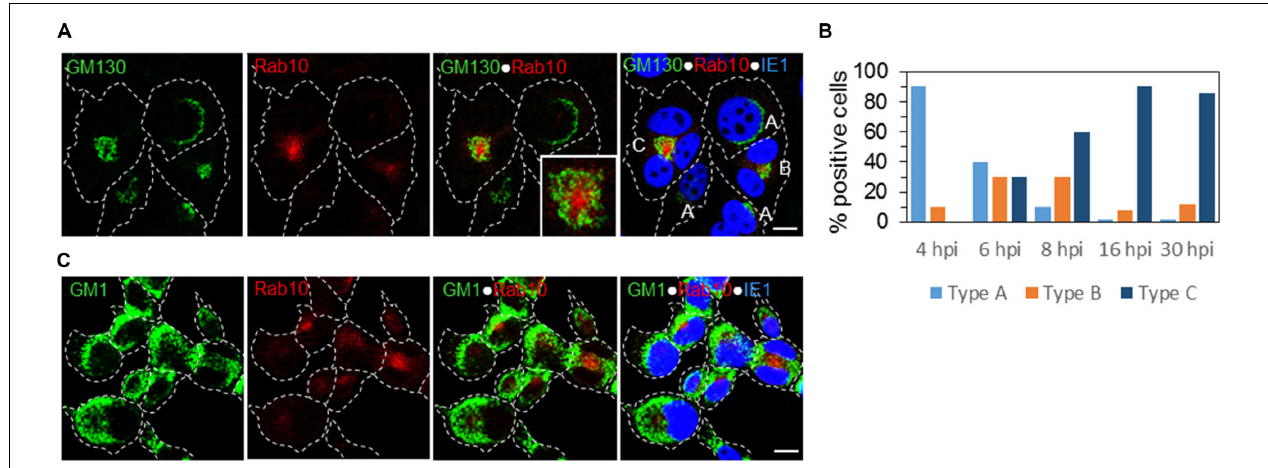
FIGURE 6 | The earliest landmarks of membranous organelle rearrangements in the course of MCMV infection. The cells were infected with (cid:49) m138-MCMV (MOI 5), and intracellular distribution of the cis-Golgi marker (GM130), LE marker (GM1), EE/ERC marker (Rab10), and MCMV immediate-early protein (IE1) was analyzed by triple immunofluorescence and confocal microscopy. (A) Three patterns of GM130 and Rab10 staining were detectable at 6 h p.i.: A, represents a typical distribution of the Golgi stacks close to the nucleus and weak or almost undetectable recruitment of Rab10; B, represents recruitment of Rab10 with a displacement of the GM130-positive membranes: and C, represents fully developed reorganization of juxtanuclear organelles with a ring-like redistribution of the GM130-positive membranes surrounding large juxtanuclear accumulation of membranes that recruit Rab10. (B) Percentage of cells demonstrating the three patterns in the course of MCMV infection. (C) Relation of the juxtanuclear Rab10-positive membranes to LEs at 6 h p.i. Cell borders are indicated by fine dotted lines and nuclei by fine dashed lines. Insert represents the boxed area acquired at higher magnification. Bars, 10 µ m. 2-column fitting image.